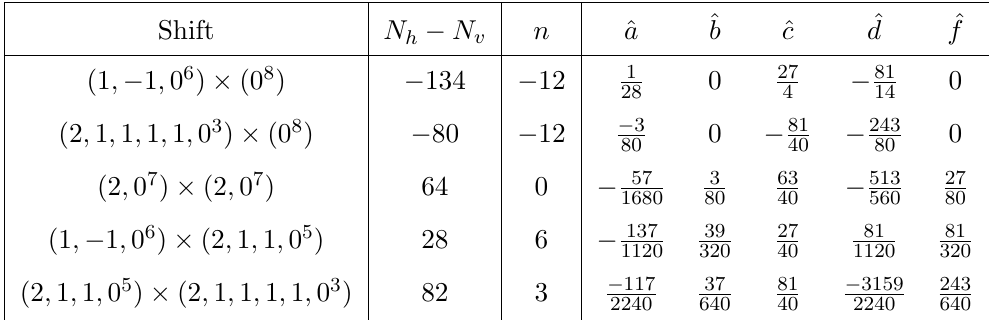
Table 3 . Z r;s for di(cid:11)erent embeddings with K 3 as T 4 =Z 3 and N = 3 CHL orbifold with one new Wilson line. The values of n were listed in